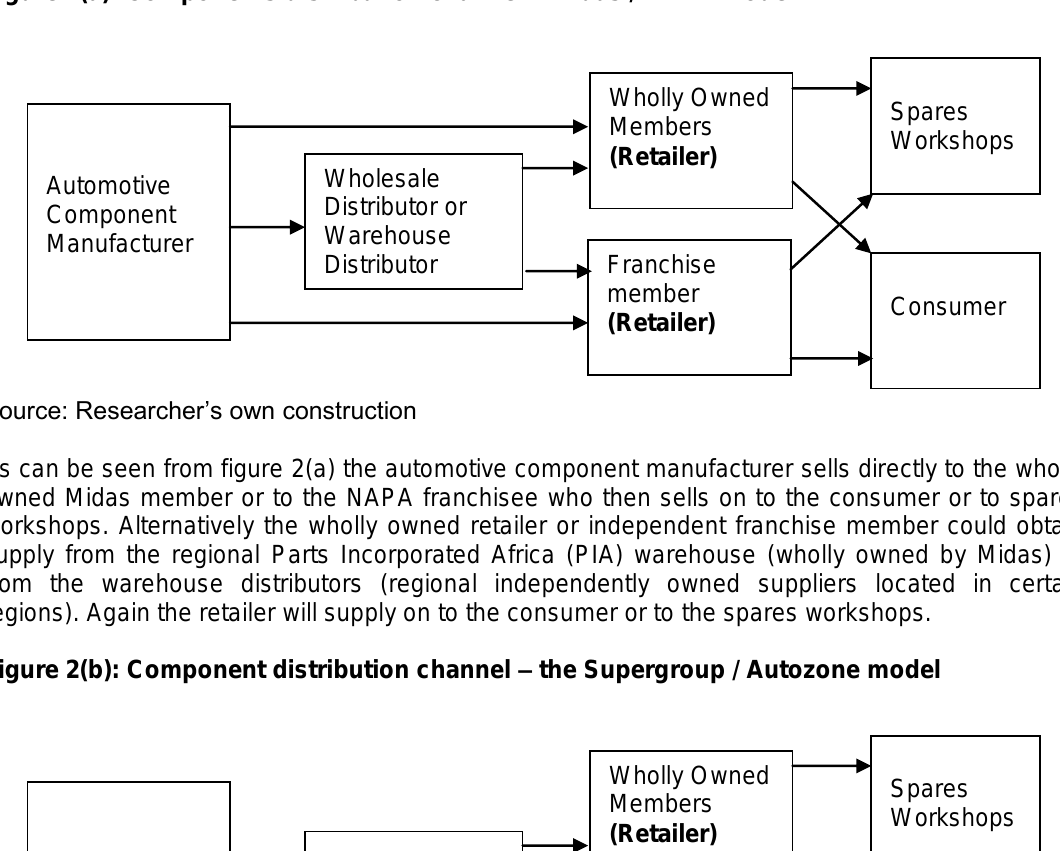
Figure 2(a): Components distribution channel – Midas / NAPA model